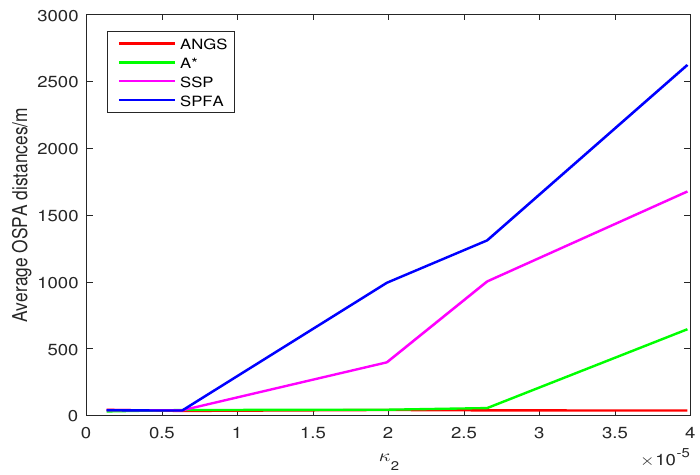
Figure 10. The average OSPA distances versus the Type II clutter intensity in scenario 2.